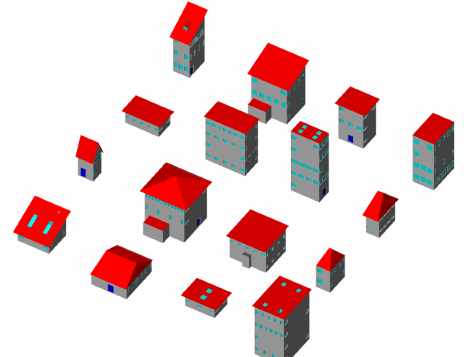
Figure 9. A CityGML LoD3 model representing buildings generated with procedural